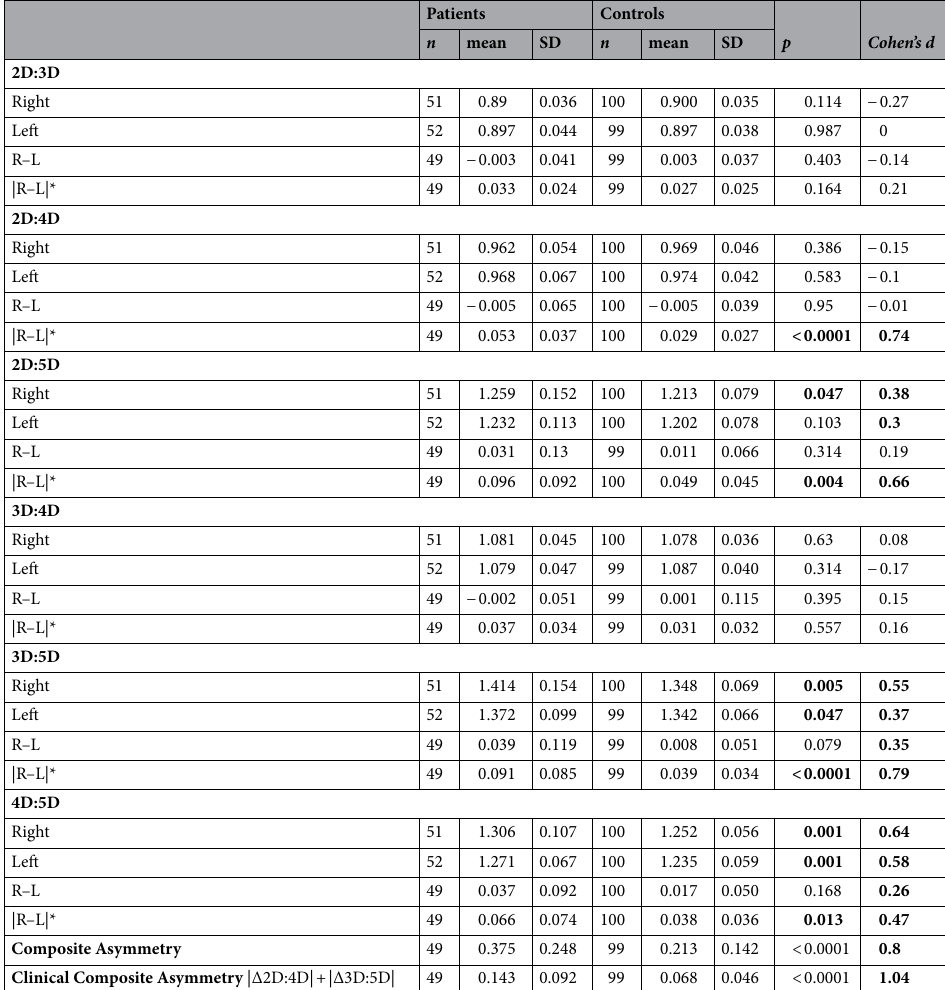
Table 3. Patient and control means and SD’s for six digit ratios (2D:3D; 2D:4D; 2D:5D;3D:4D; 3D:5D; 4D:5D) and their signed and unsigned asymmetries. Values of p and Cohen’s d are given for differences between patients and controls (t test). Negative d denotes lower values in patients compared to controls and positive d denotes higher values in patients compared to controls. All significant patient/control differences (in bold) involve digits 2D and 5D and all have positive values of d, i.e. patients > controls. *Mann–Whitney